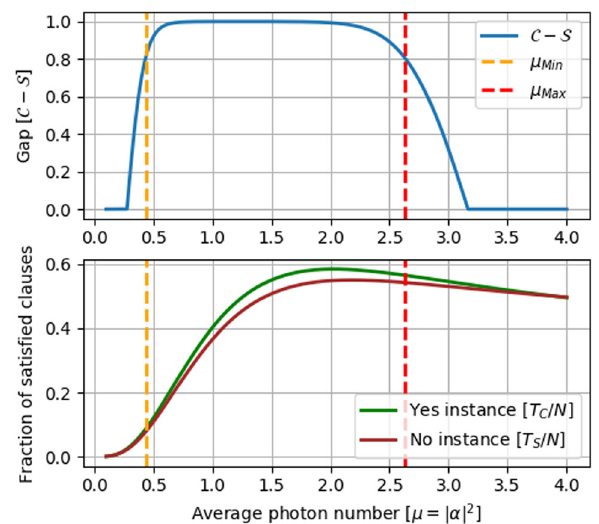
Fig. 2 Numerical results. (Top) Gap between completeness and soundness as a function of the mean photon number μ = ∣ α ∣ 2 , for N = 10,000, δ = 0.15, ν = 0.91. The two vertical lines correspond to the minimum and maximum μ in order to have at the same time completeness C > 0 : 9 and soundness S < 0 : 6. (Bottom) Fraction of measured satis fi ed clauses as a function of μ . As the mean photon number increases the number of satis fi ed clauses in the NO instance overcomes the one in the YES